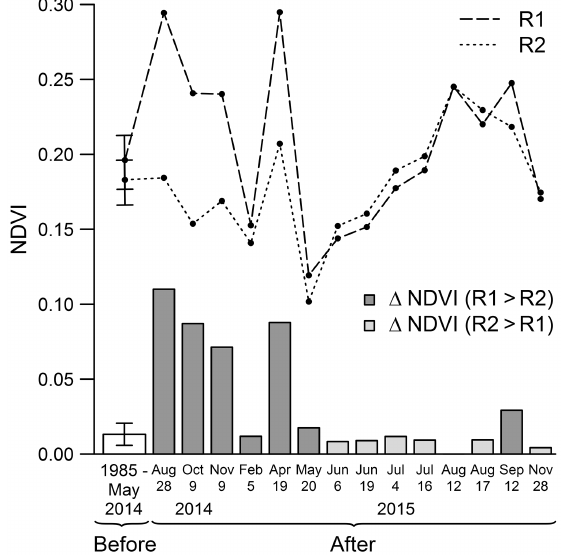
Figure 8. R1 control reef (dashed line), R2 impacted reef (dotted line) mean NDVI, and R1 and R2 (cid:49) NDVI (grey bars). Mean NDVI was calculated for each image of the time series based upon the dis- tance buffer derived from the spatial metrics. R1 and R2 first points correspond to their respective mean NDVI before the BACI exper- iment (mean ± 95% CI). The white bar corresponds to the mean difference observed between the patches before the BACI experi- ment (mean ± 95% CI). The other values represent the means and differences observed between the patches on each image acquired after the BACI